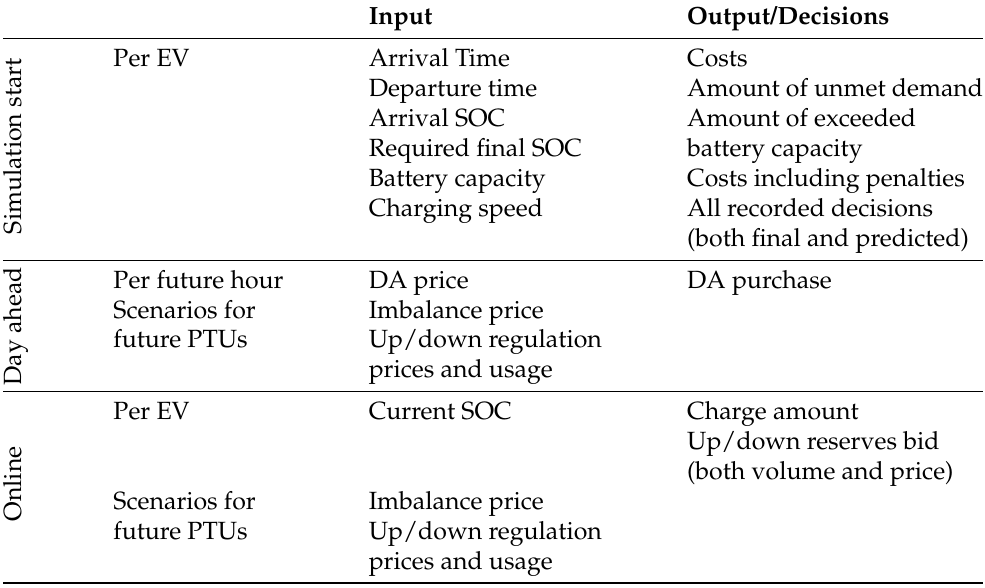
Table 2. An overview of the inputs and outputs for the solution models. At the start, information is provided for every flexible load. Then day-ahead information is provided and day-ahead purchase decisions are made. Then in the online simulation, every time step, new scenario data are provided and new decisions are made. For explanations of unmet demand and exceeded battery capacity, see Section